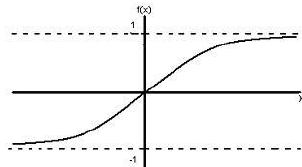
Fig. 1 Activation Function of Bipolar